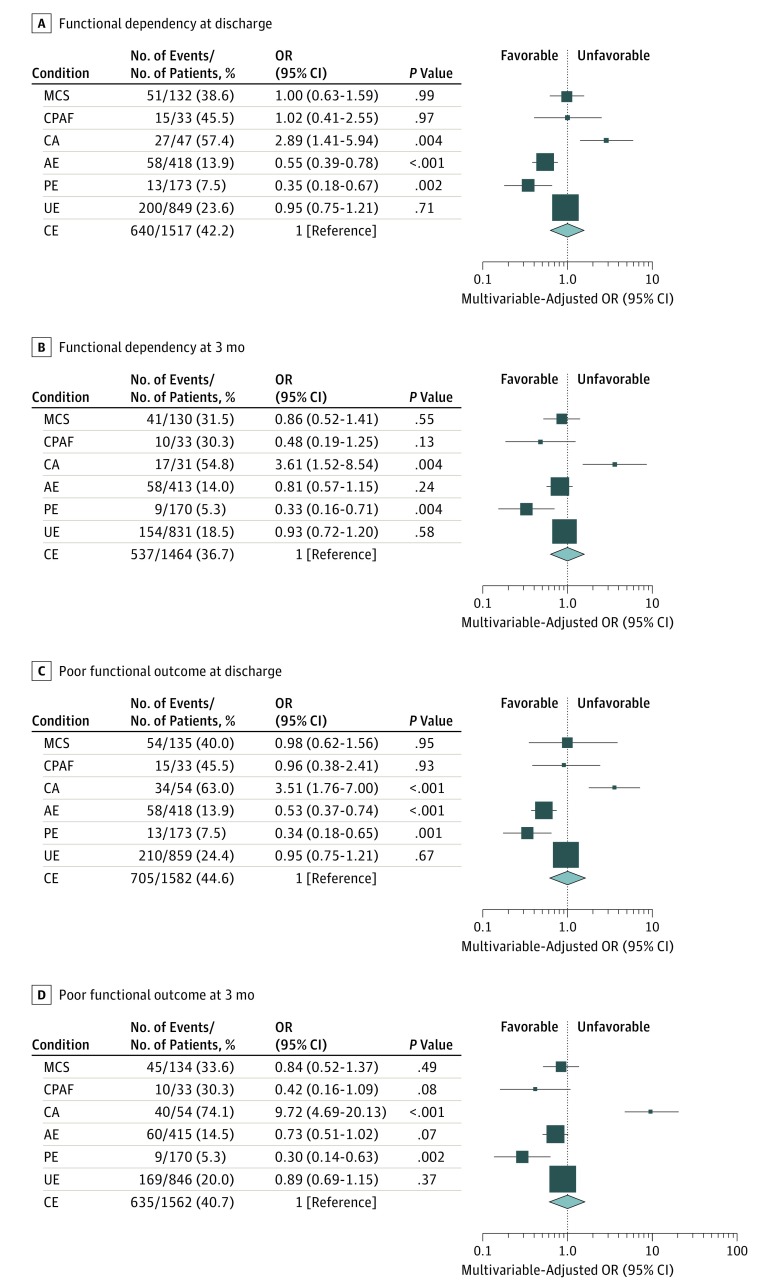
Functional OutcomesFunctional dependency (A and B) and poor functional outcome (C and D) in embolic stroke of undetermined source are shown according to each potential cause compared with cardioembolic stroke (CE). Functional outcomes were evaluated at discharge (A and C) and at 3 months of stroke onset (B and D). Odds ratio (OR) (square) and 95% CI (bars) of functional outcomes are shown for each potential cause with reference to CE (diamond). The multivariable model included age, sex, National Institutes of Health Stroke Scale score (measuring neurological severity) on admission (mild if 0-4, moderate if 5-14, and severe if ≥15), and reperfusion therapy. The sizes of squares or diamonds are proportional to the sizes of the subgroups of each potential cause. Patients who died during hospitalization or within 3 months were excluded from the analysis for functional dependency. Patients who were lost to follow-up at 3 months were also excluded from the analysis for functional outcome at 3 months. AE indicates arteriogenic emboli; CA, cancer associated; CPAF, covert paroxysmal atrial fibrillation; MCS, minor-risk potential cardioembolic sources; PE, paradoxical embolism; and UE, undetermined embolism.